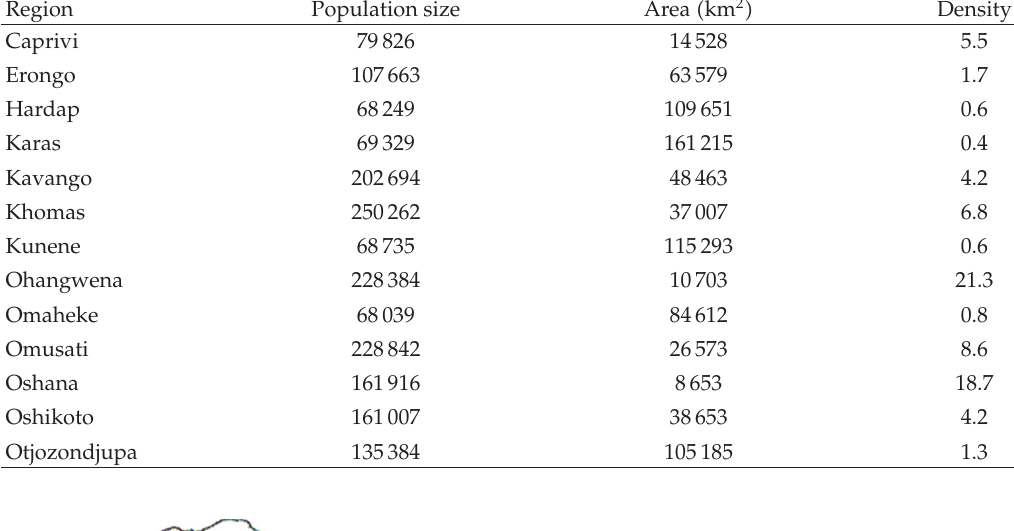
Table 1: Regional statistics as per 2001 population and housing census.